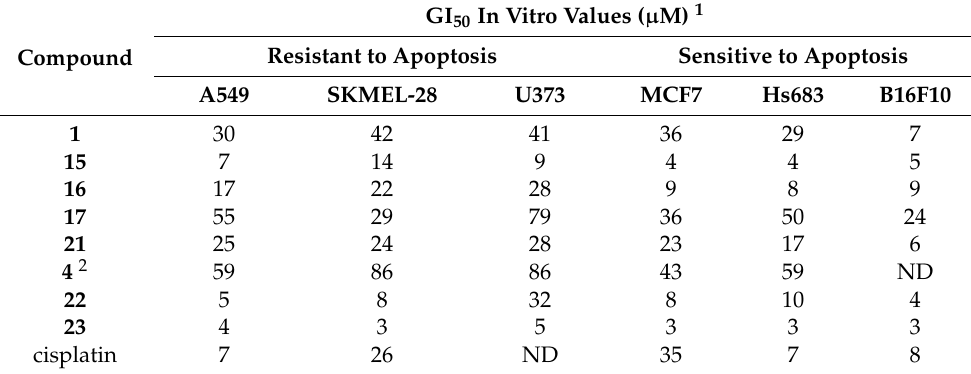
Table 1. In vitro growth inhibitory effects of cross-linking agents in comparison with their monomeric counterparts. GI 50 In Vitro Values ( µ M)